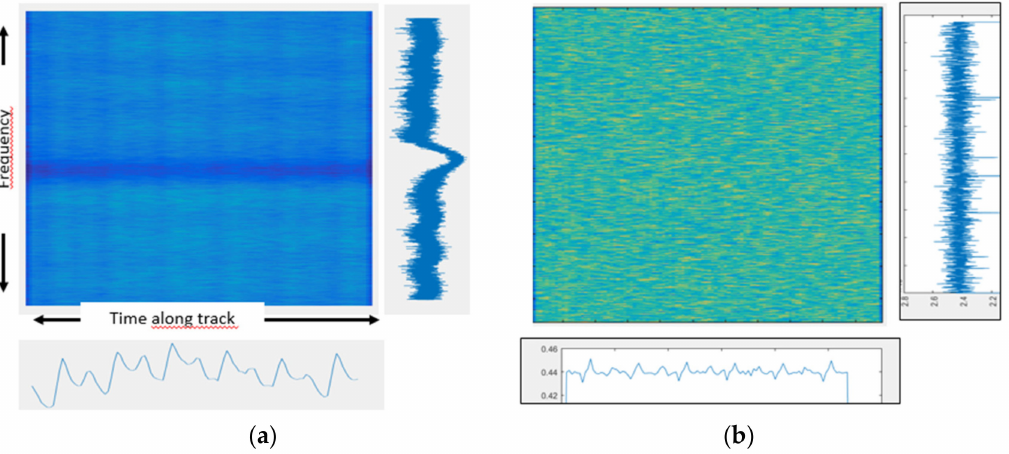
Figure 5. Example of a spectrogram of noise data before ( a ) and after ( b ) compensation for the ripples in frequency and time. The residual along-track ripple is less than 0.1